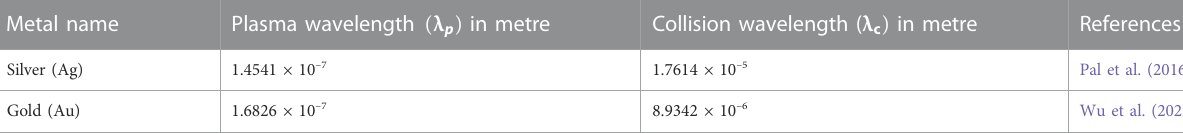
TABLE 1 Plasma and Collision wavelength for Ag and Au metal as per Drude Model at λ = 633 nm wavelength. Metal name